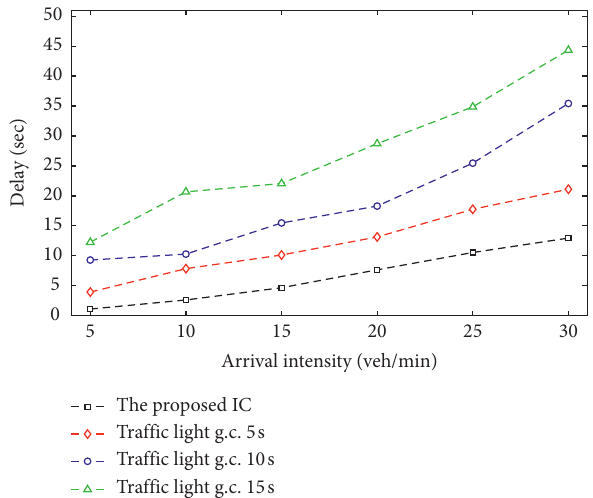
Figure 15: Second case study: delay at the traffic intersection under the proposed IC and conventional traffic signal control with green cycles (g.c.s) of 5s, 10s, and 15s, respectively.